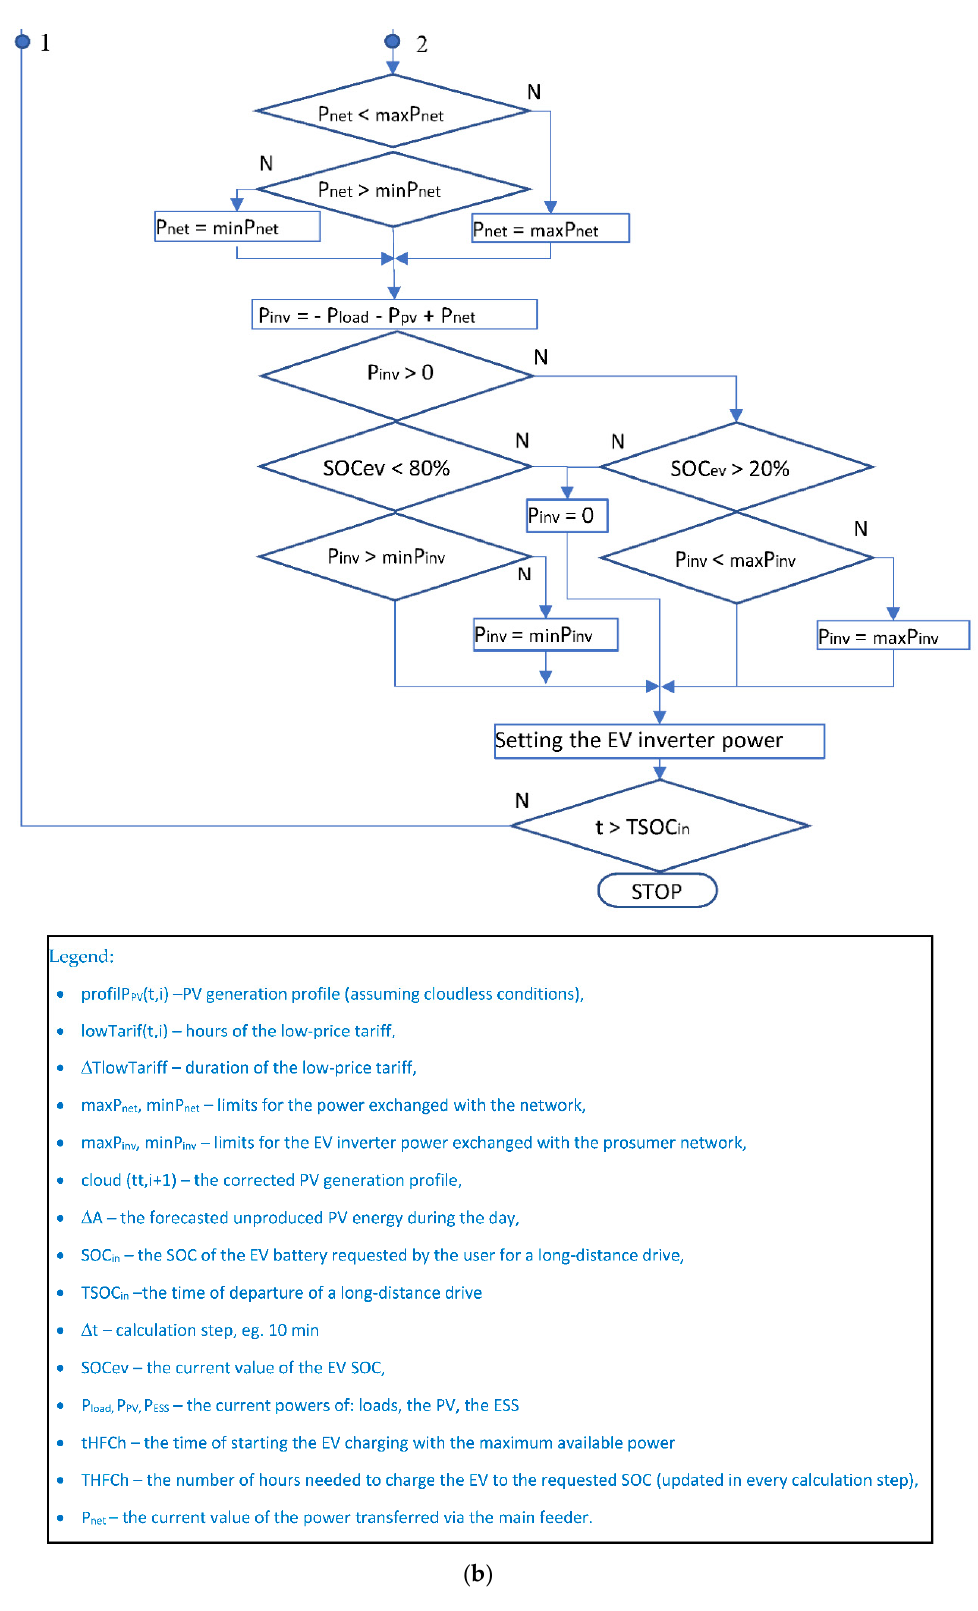
Figure 2. ( a ). Flow chart of the control algorithm — part A. ( b ) Flow chart of the control algorithm — part B.